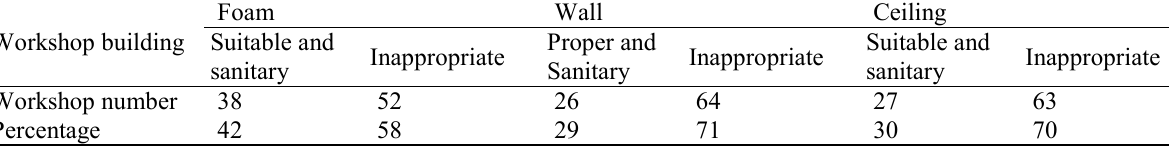
Table 1. Construction status of workshops Workshop building